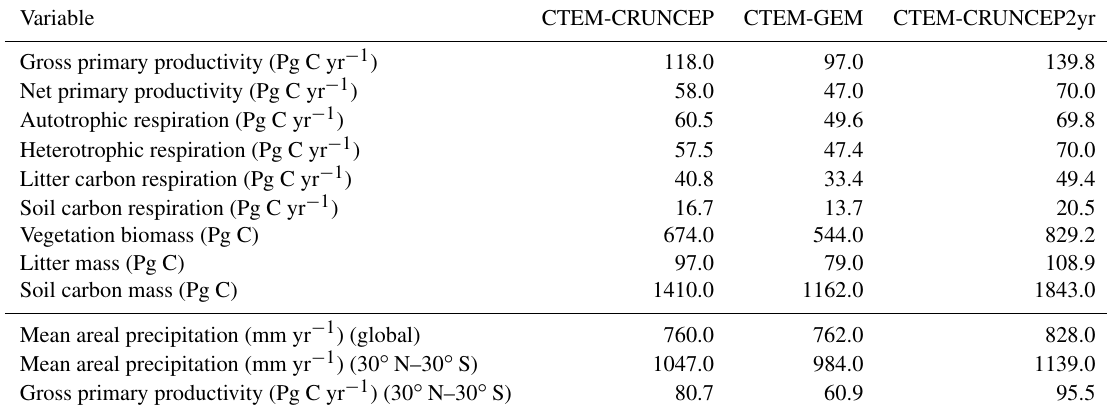
Table 3. Simulated global values of primary carbon pools and fluxes for the spin-up simulations using CTEM-CRUNCEP, CTEM-GEM and CTEM-CRUNCEP2yr. Values are a 20-year average at the end of model simulations. Mean areal precipitation (global land and for the 30 ◦ N–30 ◦ S land band) averaged for the 1901–1940 period is used to spin up CTEM-CRUNCEP, and for the 2009–2010 period used to spin up CTEM-GEM and CTEM-CRUNCEP2yr, and the correspondence GPP